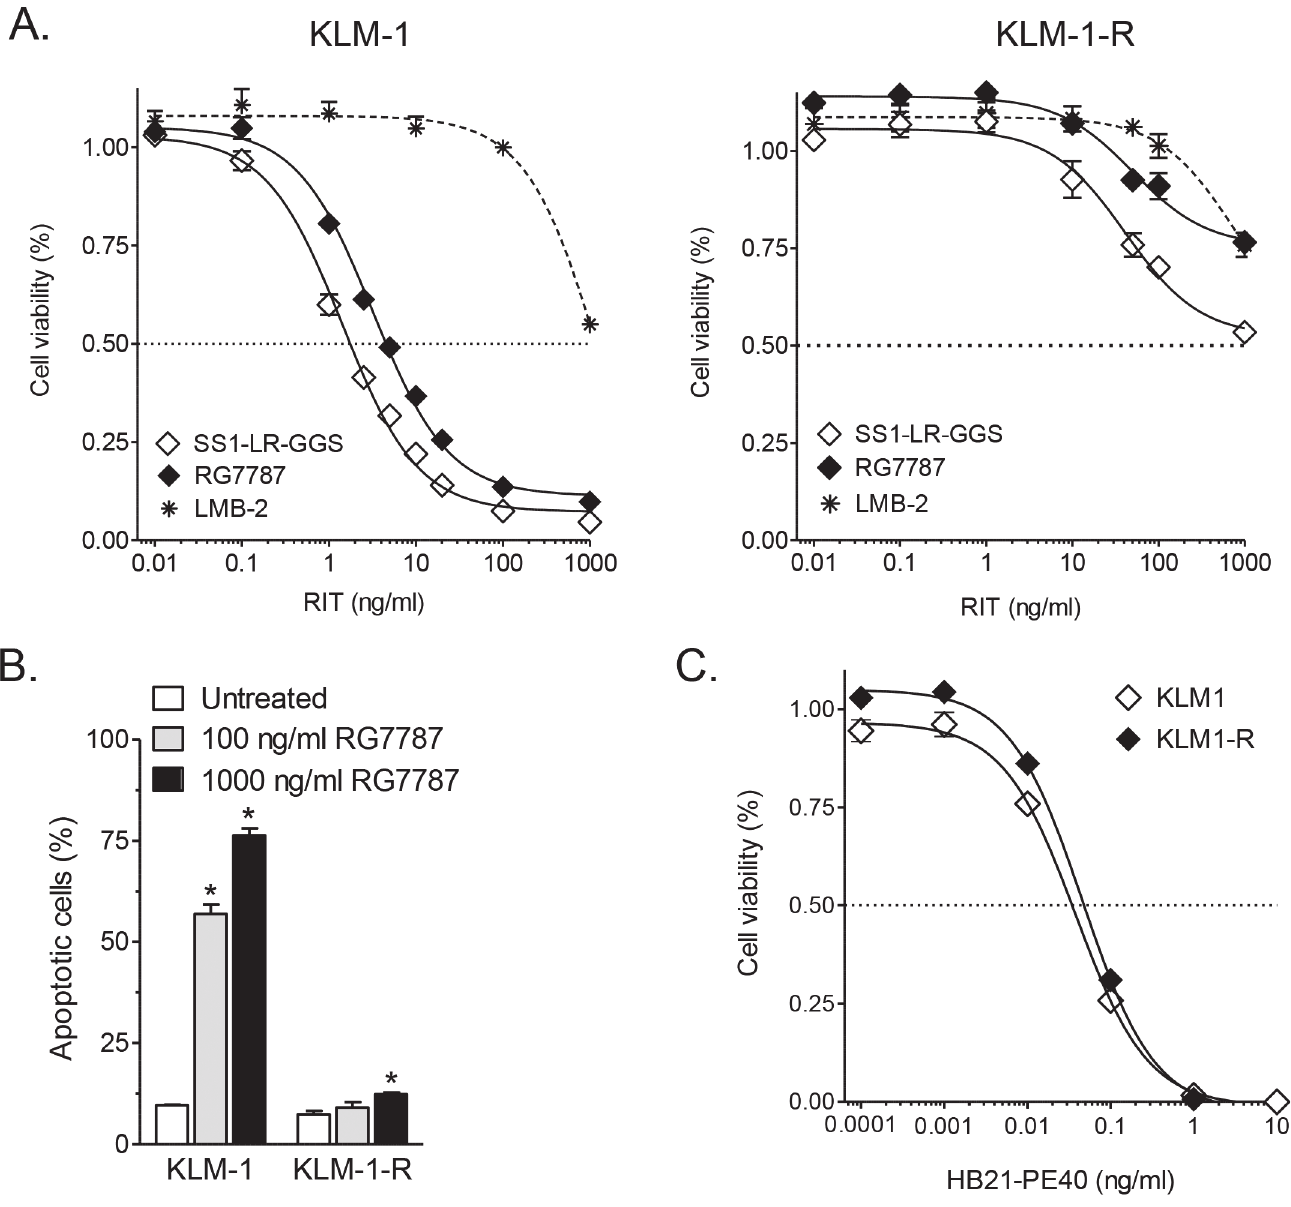
Fig 1. Activity of anti-mesothelin, anti-CD25 and anti-CD71 immunotoxins in KLM-1 and KLM-1-R. A : KLM-1 and resistant KLM-1 (KLM-1-R) cells were incubated for 72 hrs with the anti-mesothelin SS1-LR-GGS, RG7787 or anti-CD25 LMB-2 as a control. Growth inhibition was evaluated with an ATP cell viability assay. With IC 50 s below 10 ng/ml, KLM-1 is sensitive to the anti-mesothelin RITs, which is not the case for KLM-1-R (IC 50 s > 1 μ g/ml). 1 μ g/ml LMB-2 decreased cell viability, indicating that this RIT concentration induces non-specific uptake. B : KLM-1 and KLM-1-R cells were incubated for 72 hrs with 100 or 1000 ng/ml RG7787. Apoptosis was evaluated with the Annexin V-PE Apoptosis Detection Kit I. RG7787 induces a significant increase in apoptotic KLM-1 cells, whereas KLM-1-R cells shows no meaningful increase in apoptosis. C : KLM-1 and KLM-1-R cells were incubated for 72 hrs with HB21(Fv)-PE40. Growth inhibition was evaluated with an ATP cell viability assay. Both cell lines are highly sensitive to this